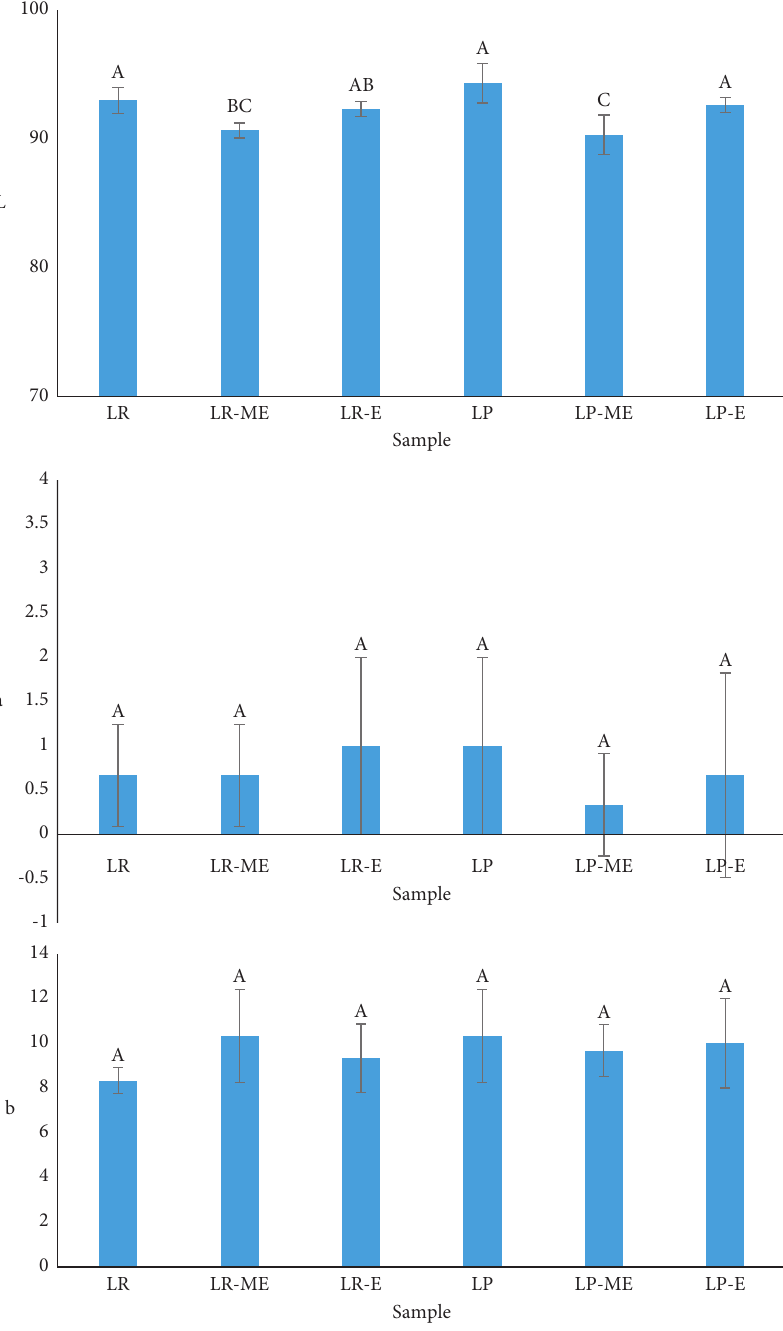
Figure 8: Color parameters of probiotic yogurt. LR ( L. rhamnosus ), LR-ME (encapsulated L. rhamnosus in multilayer emulsion), LR-E (encapsulated L. rhamnosus in emulsion), LP ( L. plantarum ), LP-ME (encapsulated L. plantarum in multilayer emulsion), and LP-E (encapsulated L. plantarum in